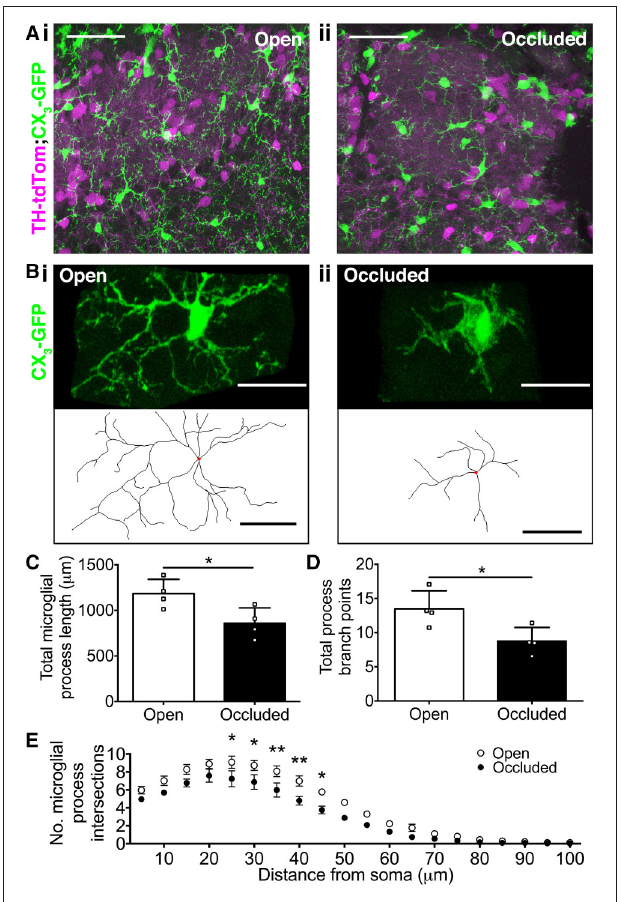
FIGURE 4 | Loss of olfactory input drives changes in microglial morphology. (A,B) (i) More ramified microglial morphology in open OB vs. (ii) more amoeboid microglial morphology in occluded OB. (A) Scale bars: 50 µ m. (B) Lower panels show reconstructions (red dots: somata). Scale bars: 20 µ m. (C) Shorter process length in occluded OBs ( * p = 0.031, t = 2.82, t -test). (D) Fewer process branch points in occluded OBs ( * p = 0.029, t = 2.85,